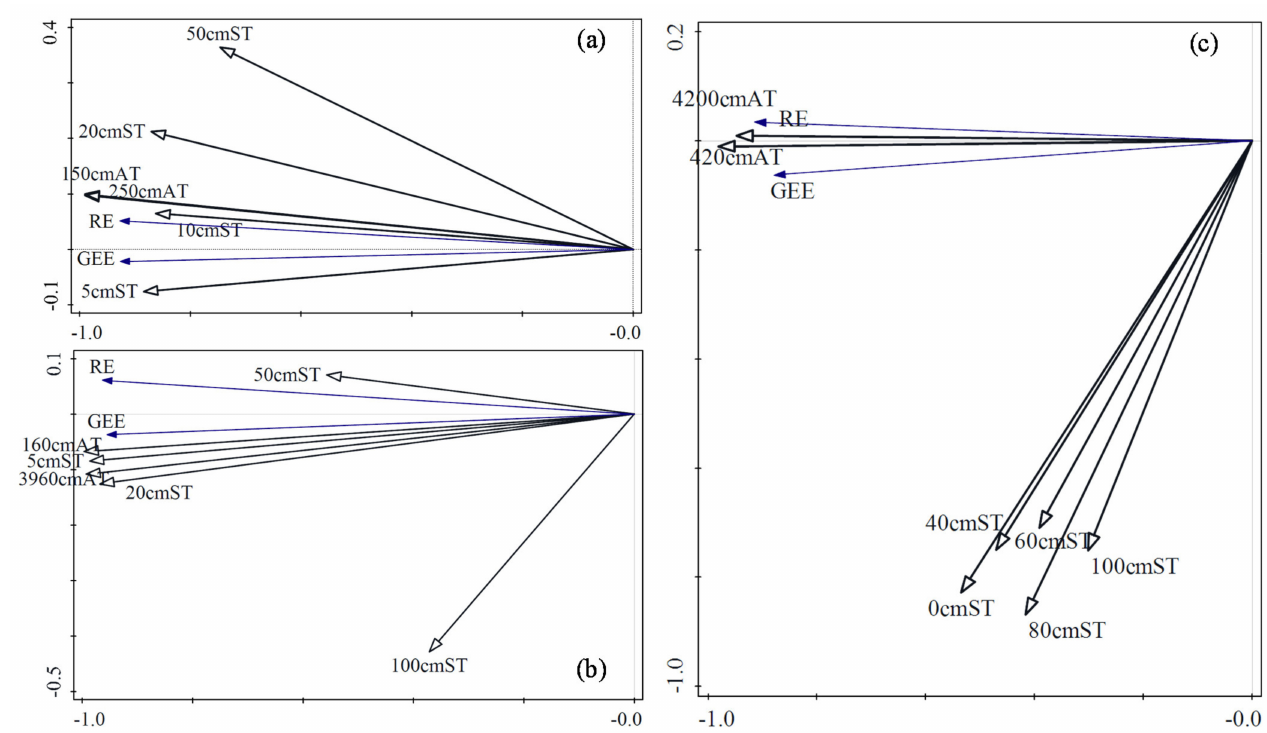
Figure 3. Redundancy analysis on temperature with ecosystem respiration and gross ecosystem exchange in temperate grassland ( a ), subtropical artificial coniferous forest ( b ), and tropical rain forest ( c ). Note: RE is ecosystem respiration, GEE is gross ecosystem exchange, AT is air temperature, ST is soil temperature, the number in front of ST and AT is the distance from the